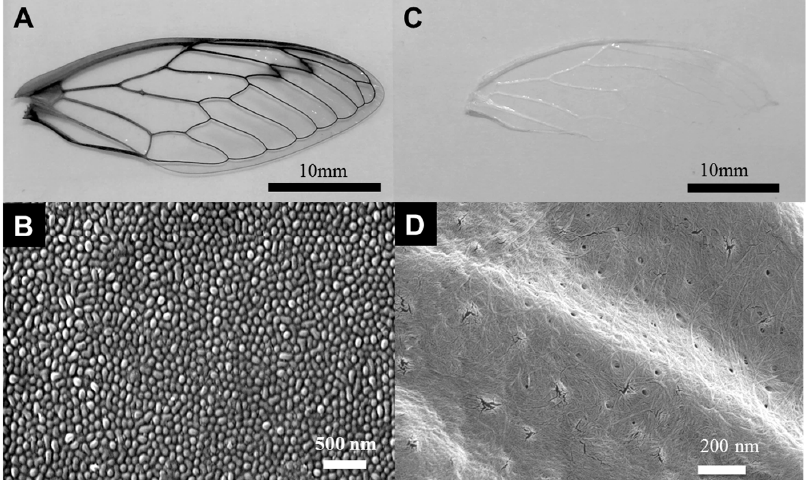
Figure 1. The source of chitin for the colloidal/nanosphere lithography substrate. ( A ) A forewing from the periodic 17-year cicada Brood II Magicicada septendecim ; ( B ) SEM micrograph of the inter-vein (clear) regions of a wing showing an array of hemispherical nano-features, which is a rough hexagonal close-packed arrangement; ( C ) A forewing from the periodic 17-year cicada Brood II Magicicada septendecim after in situ chitin purification. Note the loss of all pigment and color from the wing; ( D ) The surface of the inter-vein region showing the loss of the array of nanofeatures, and the presence of a nanoscale fibrous network.